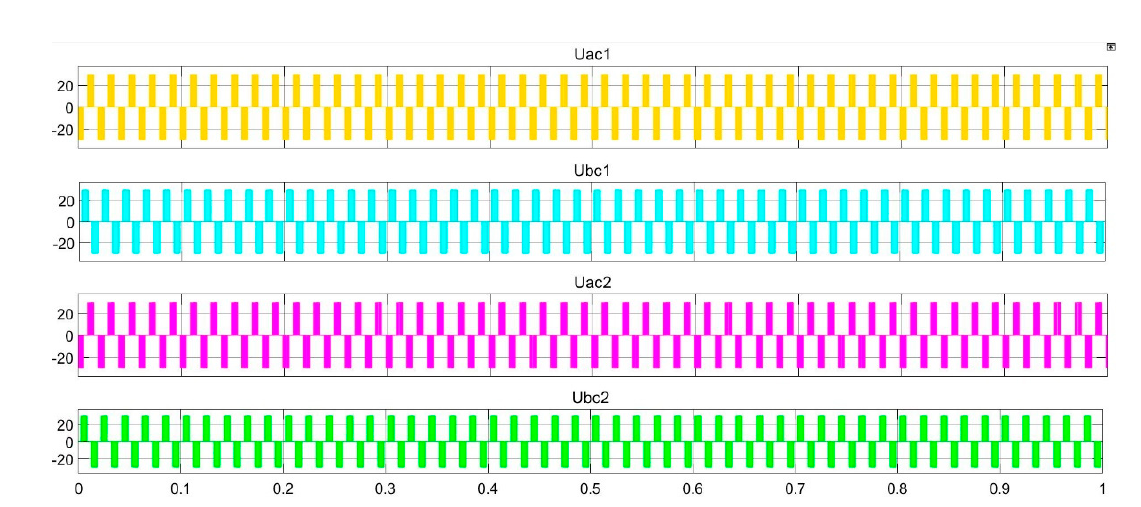
Figure 14. The simulation waveforms based on two topologies.